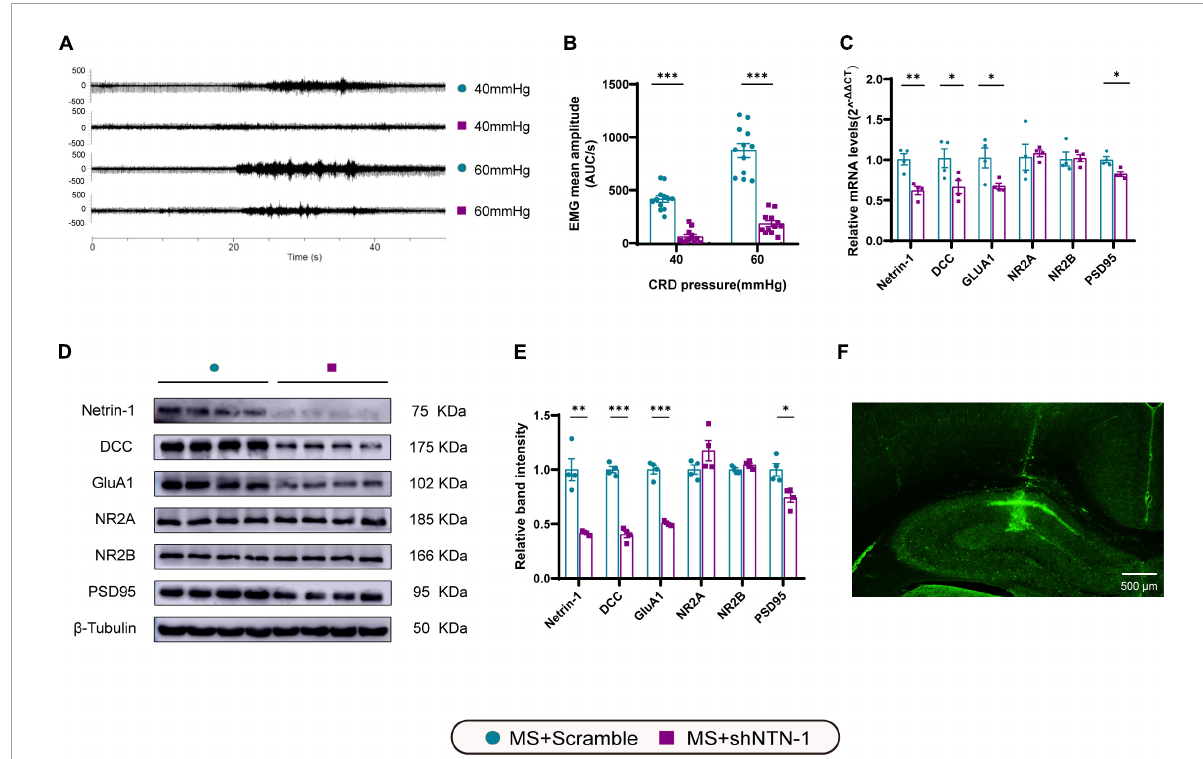
FIGURE7 Knockdown of Netrin-1 (NTN-1) in hippocampal CA1 regions decreased not only visceral sensitivity but also the expression levels of mRNA and proteins of Netrin-1, DCC, GluA1, and PSD95. (A) The representative external abdominal oblique muscle EMG recordings. (B) VMR amplitudes to 40 and 60 mmHg CRD were significantly reduced in rats expressing Lenti-shNTN-1 (MS + shNTN-1) than in rats injected Lenti-Scramble (MS + Scramble). MS + Scramble: n = 12. MS + shNTN-1: n = 12. All data were given as mean ± SEM. ∗∗∗ P < 0.001, two-tailed unpaired Student’s t -test. (C) The mRNA and (E) protein expressions of Netrin-1, DCC, GluA1, and PSD95 in the hippocampus were significantly reduced in the MS + shNTN-1 group. (D) Representative immunoblots showed the expression of Netrin-1, DCC, GluA1, NR2A, NR2B, PSD95, and β -Tubulin. (F) A representative fluorescence image confirmed the successful GFP expression in shNTN-1 infected cells in the hippocampus. Scale bar, 500 µ m. MS + Scramble: n = 4. MS + shNTN1: n = 4. All data were given as mean ± SEM. ∗ P < 0.05, ∗∗ P < 0.01, ∗∗∗ P < 0.001, two-tailed unpaired Student’s t